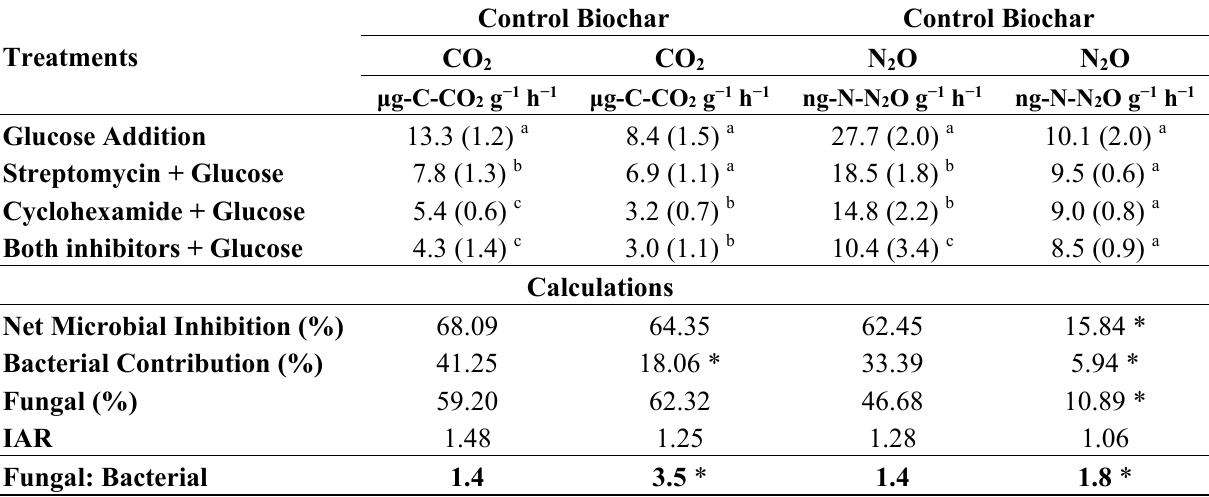
Table 3. Selective inhibitor incubation results for the agricultural